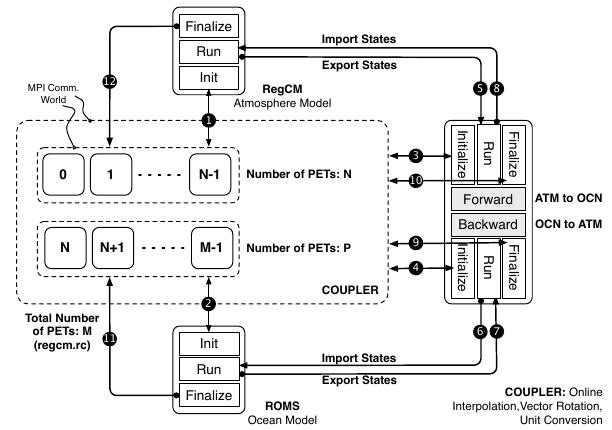
Fig. 1. General structure of coupled modelling system. The dashed rectangles indicate the MPI communication world specific to com- ponents (RegCM4, ROMS and Coupler). The solid rectangles rep- resent the component codes and the black solid circles show the execution order of the components.